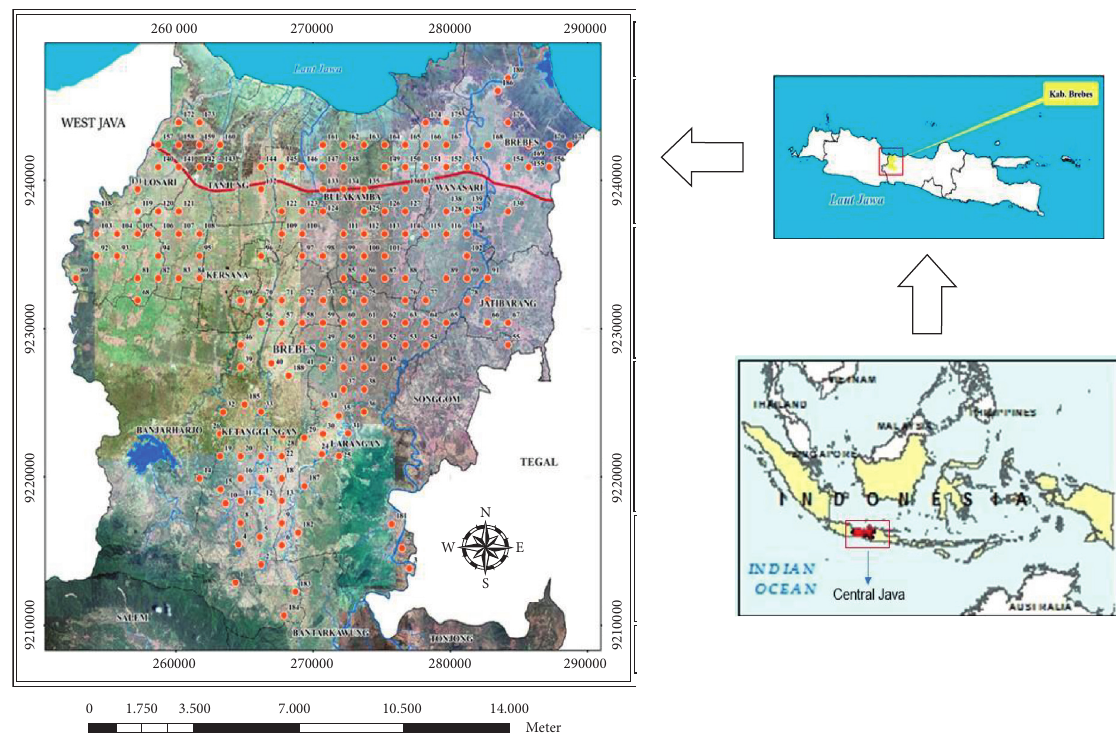
Figure 1: The study location and the soil sampling points in Brebes Regency, Central Java,